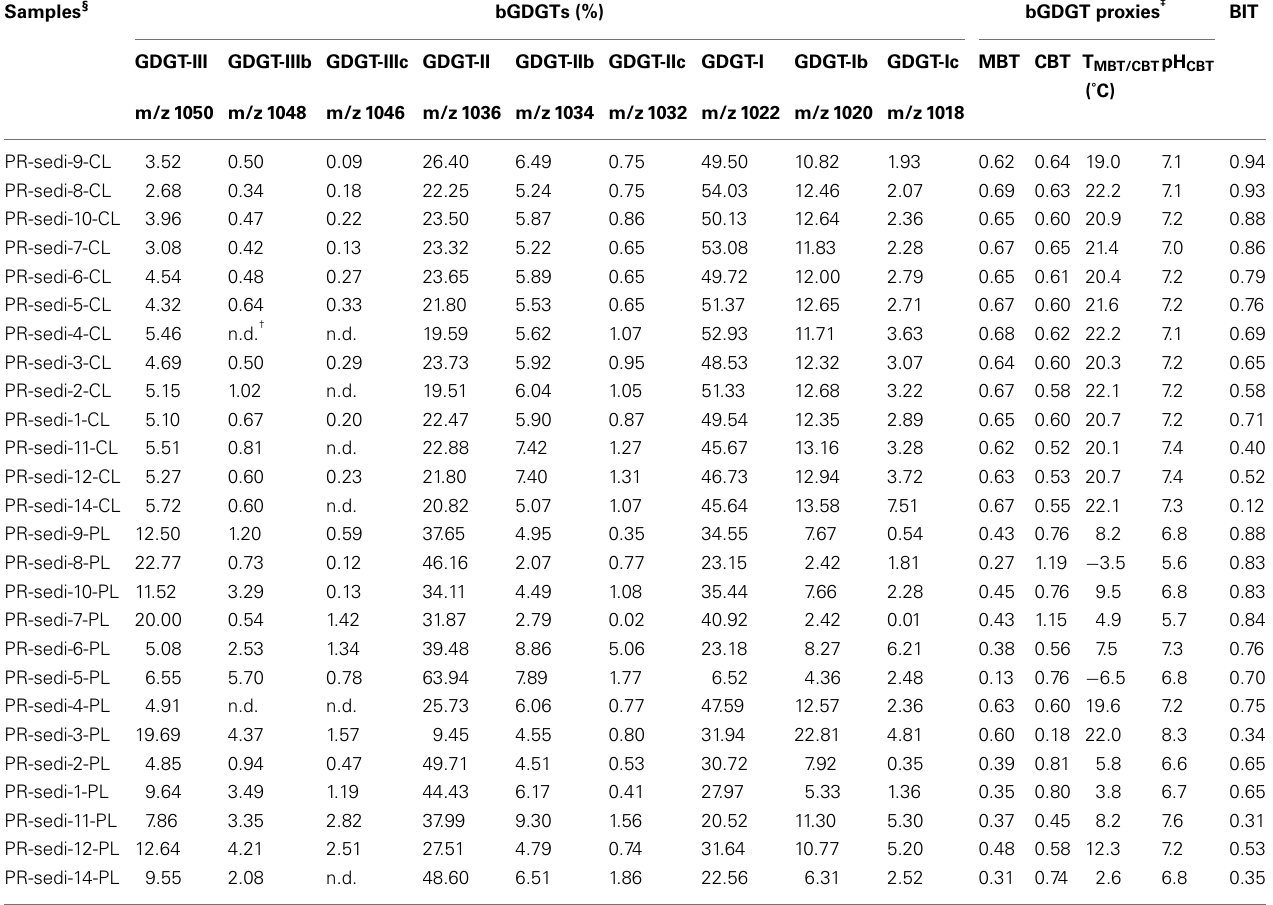
TableA1 | Sonication extraction-derived bGDGTs and proxies for sediment samples. Samples